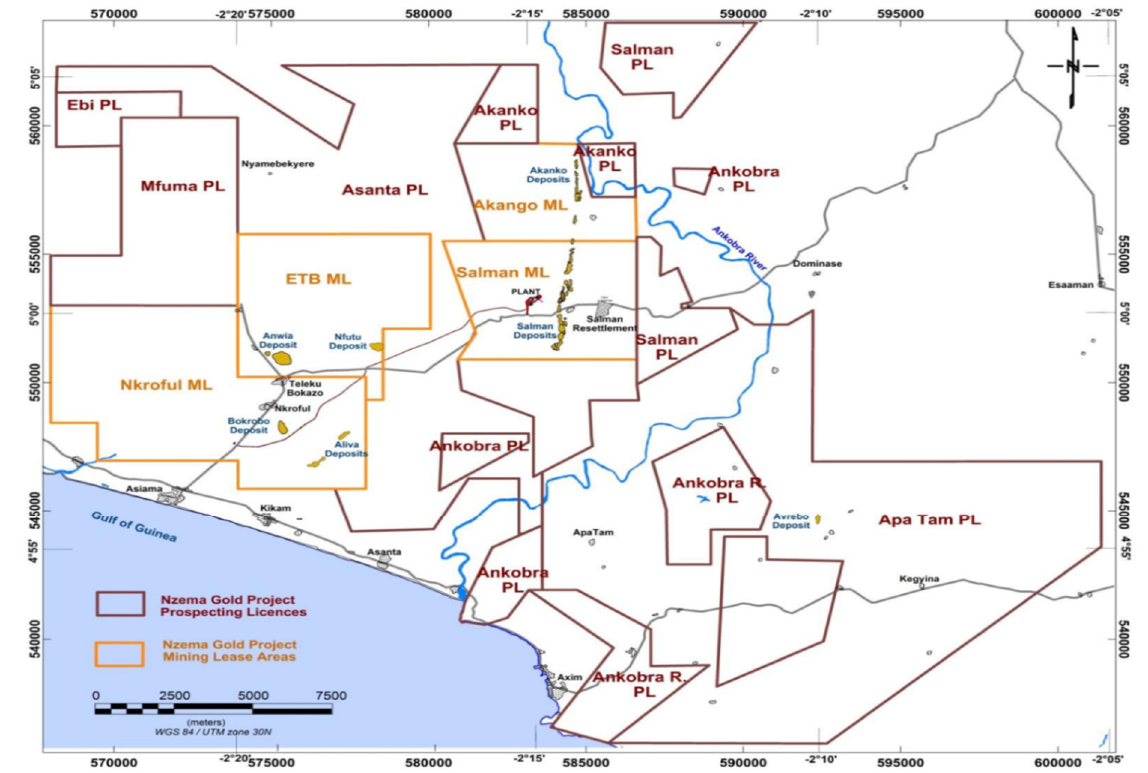
Figure 3. Mineral license perimeters, site layout, and deposit locations